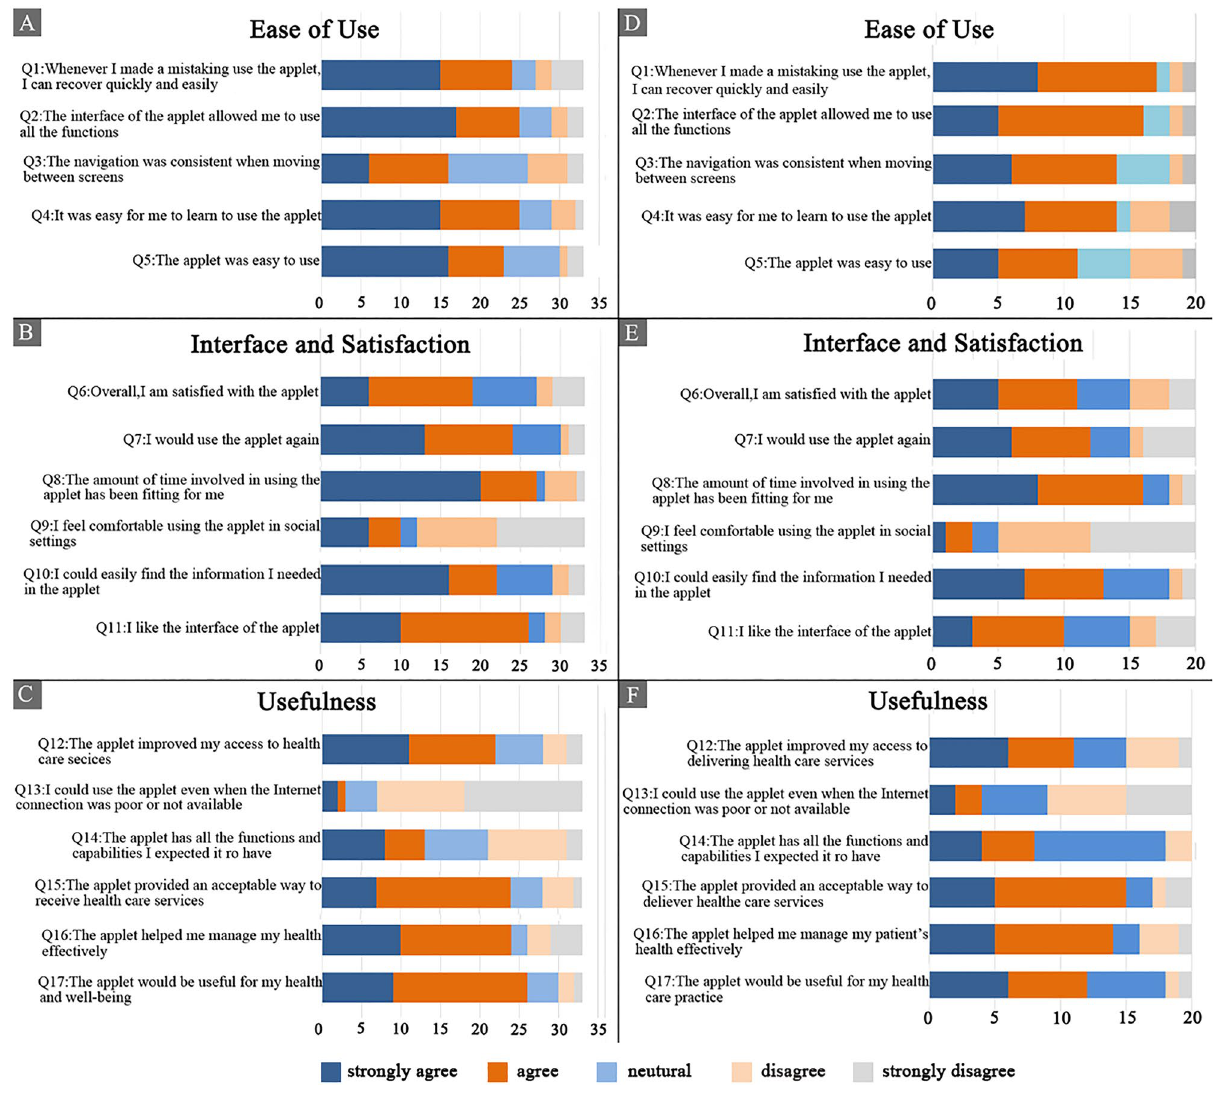
Figure 4. The results of the satisfaction questionnaire. ( A ) The questions of ease of use designed for patients. ( B ) The questions of interface and satisfaction designed for patients. ( C ) The questions of usefulness designed for patients. ( D ) The questions of ease of use designed for health services providers. ( E ) The questions of interface and satisfaction designed for health services providers. ( F ) The questions of usefulness designed for health services